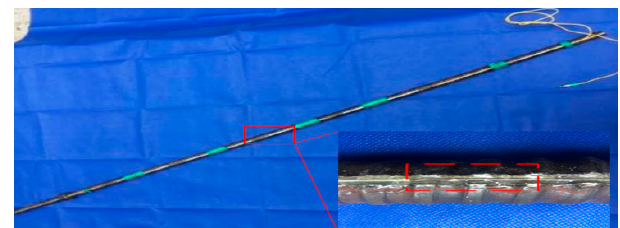
Figure 4. The post-package force-measuring bolt-shaft.